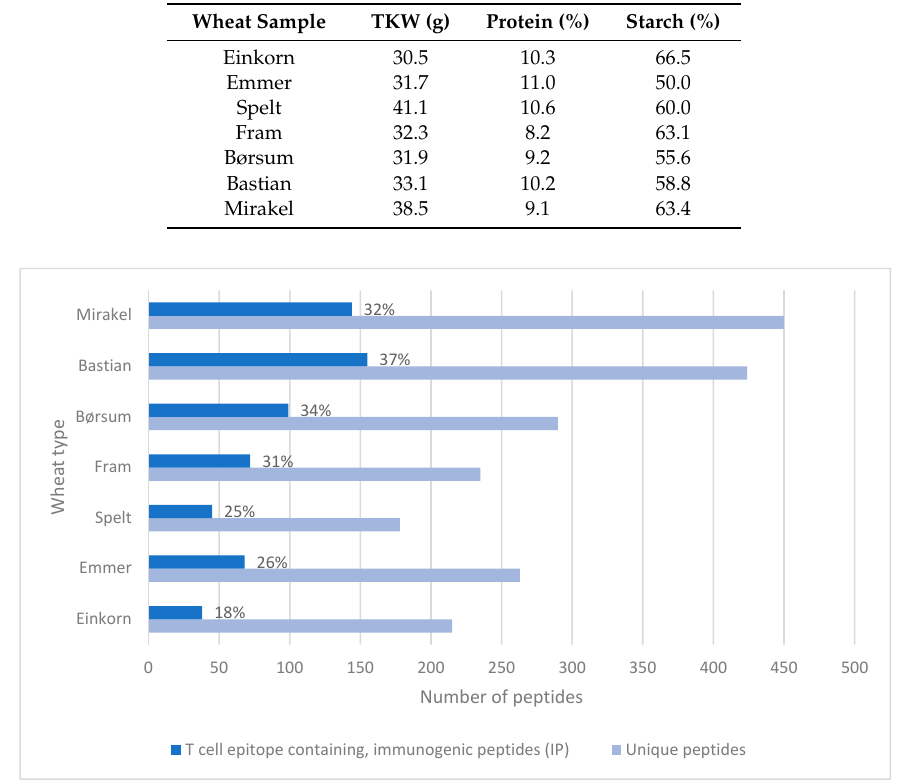
Figure 1. Representation of unique peptides identified in each wheat type and the number of T cell reactive epitopes in the unique peptides, according to Sollid, Qiao [19]. Putative immunogenic peptides are presented as a percentage of total unique peptides within each wheat type (identified by HPLC-ESI MS/MS).